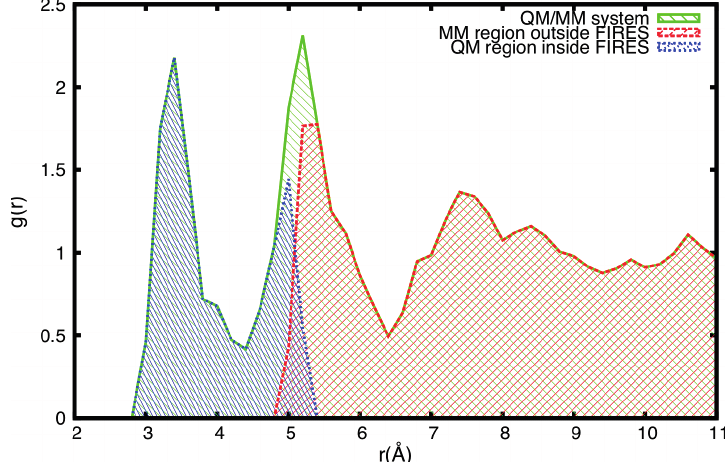
Figure 6. QM/MM Decomposition of the system with FIRES. The oxygen-ion Radial Distribution Function and its quantum and classical components for solvated Cl − . The droplet is composed of 16 QM and 250 MM waters. The flexible boundaries were implemented by the FIRES